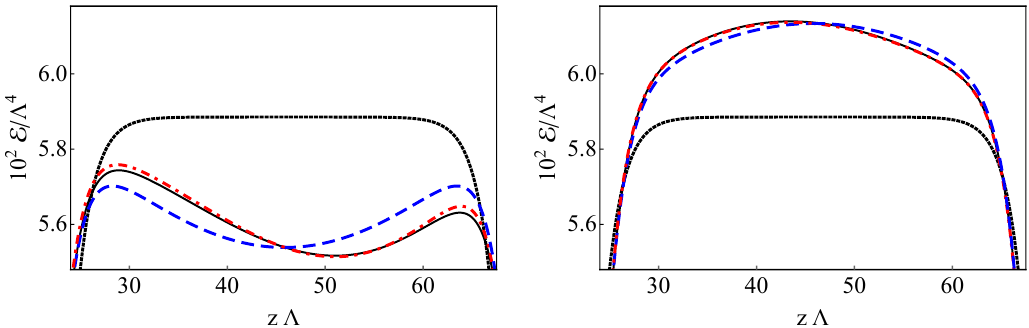
Figure 27 . The solid black curve shows snapshots of (cid:12)gure 4 at times t (cid:3) = 4820 (left) and t (cid:3) = 5065 (right). The black dotted curve is the (cid:12)nal pro(cid:12)le at asymptotically late times. The dashed blue and the dot-dashed red curves are the result of using expressions (3.9) and (3.14),